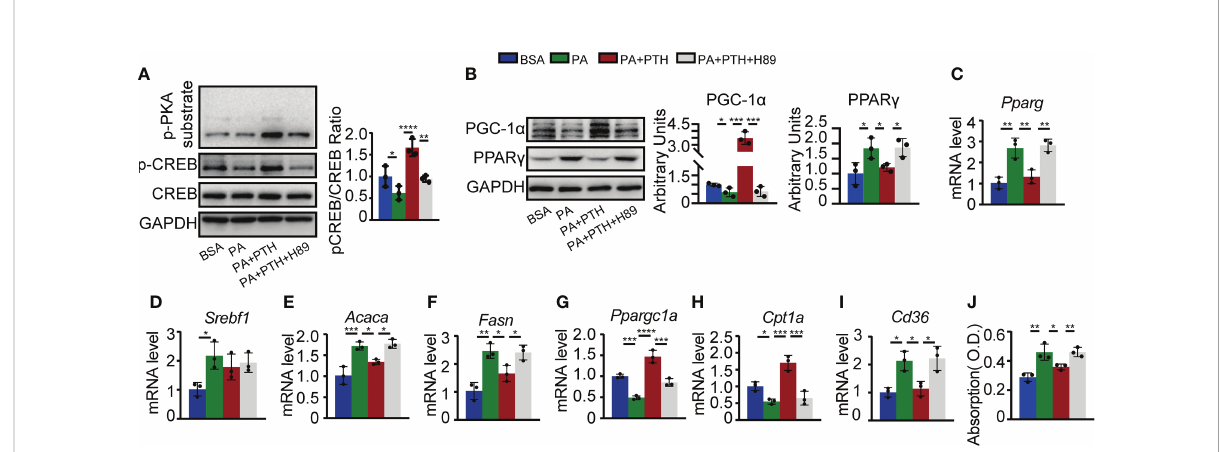
FIGURE 6 PTH regulated lipid metabolism via the cAMP/PKA/CREB pathway. Hepa1-6 cells were pretreated with 10 m M H89 for 1h, and then 0.3 mM PA and 10 nM PTH for 24h. (A) The protein levels of p-PKA substrates, p-CREB, CREB, and GAPDH. (B) The protein levels of PGC-1 a , PPAR g , and GADPH. (C – I) The mRNA levels of Pparg , Srebf1 , Acaca , Fasn , Ppargc1a , Cpt1a , and Cd36 . (J) Quantitative assessment of intracellular lipid content in PA-treated Hepa1-6 cells. Data are shown as mean ± SD, the cell experiments were repeated three times. *P < 0.05; **P < 0.01; ***P < 0.001; ****P < 0.0001 by one-way ANOVA.